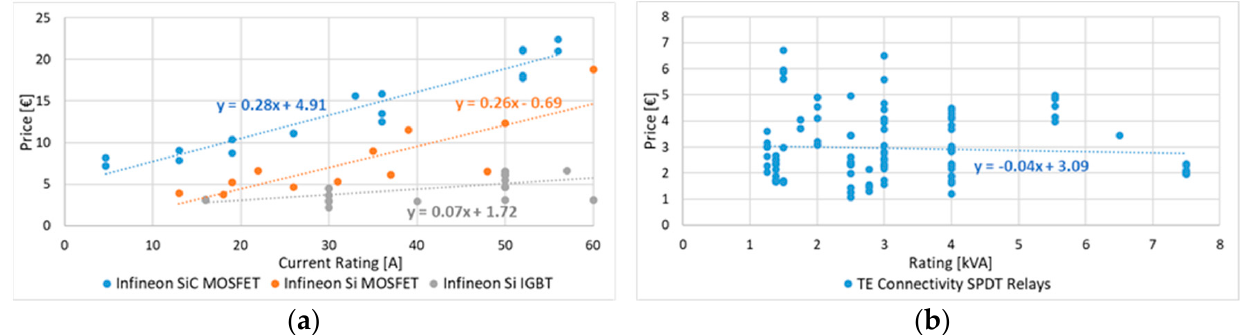
Figure 15. Cost vs. rating figures of ( a ) power semiconductor switches, ( b ) electromechanical